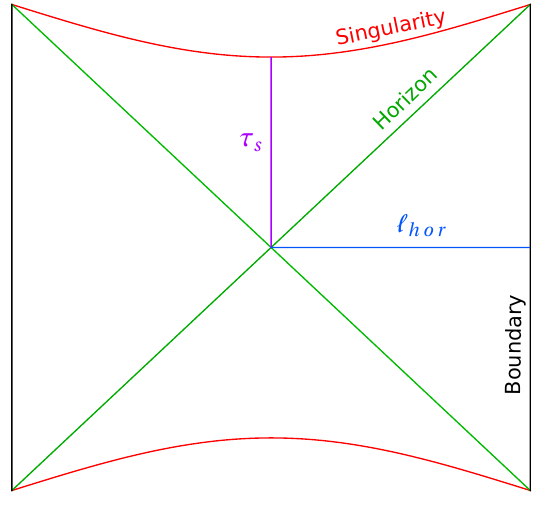
Figure 1 . Penrose diagram for the AdS-Schwarzschild metric: τ s is the time-like distance between the horizon and the singularity, and ‘ hor refers to the regularised space-like distance between the boundary and the